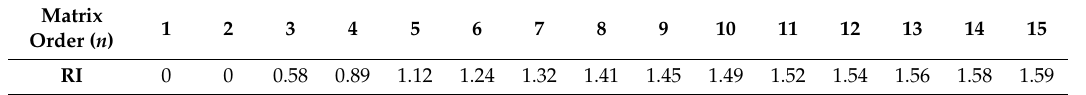
Table 2. Random consistency index.